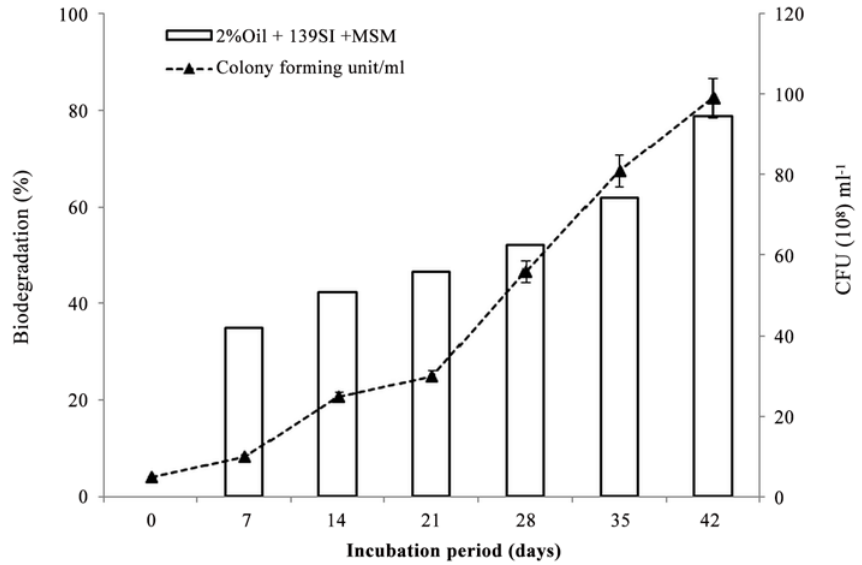
Fig 4. Growth and rate of degradation ability of strain 139SI during the incubation period. MSM: mineral salt medium, CFU: colony-forming unit.